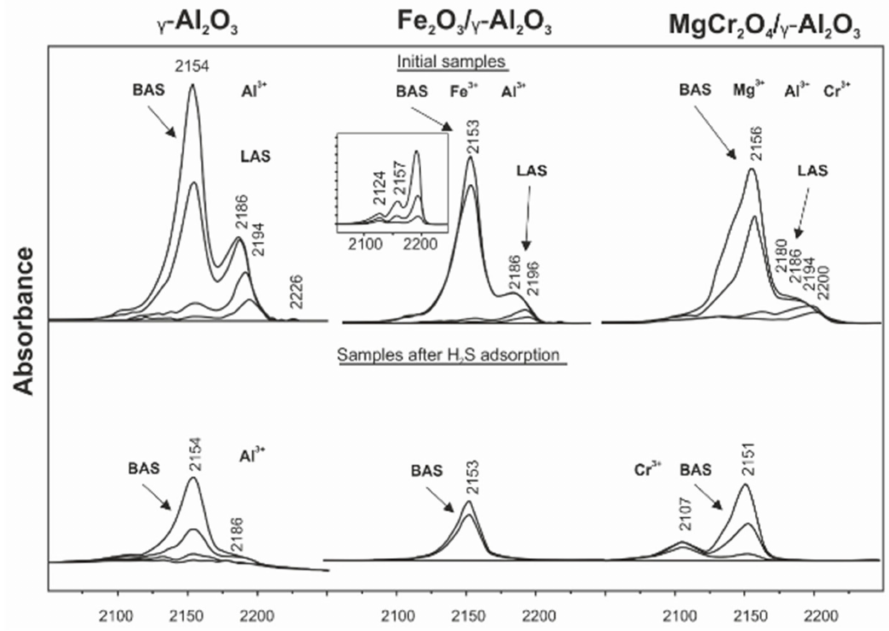
Figure 10. IR spectra of adsorbed CO: initially and after H 2 S